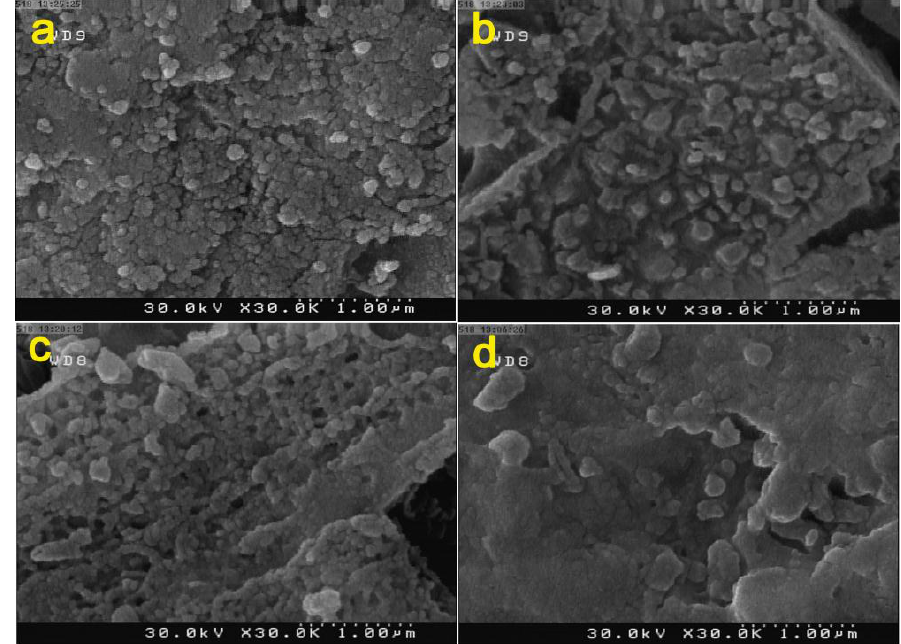
Figure 4. The SEM images of CuO nanostructures engraved on the Cu foil surface in different synthesis conditions. ( a ) Without any stabilizer or surfactants; and in the presence of ( b ) PEG 6000; ( c ) SDS; ( d ) CTAB.